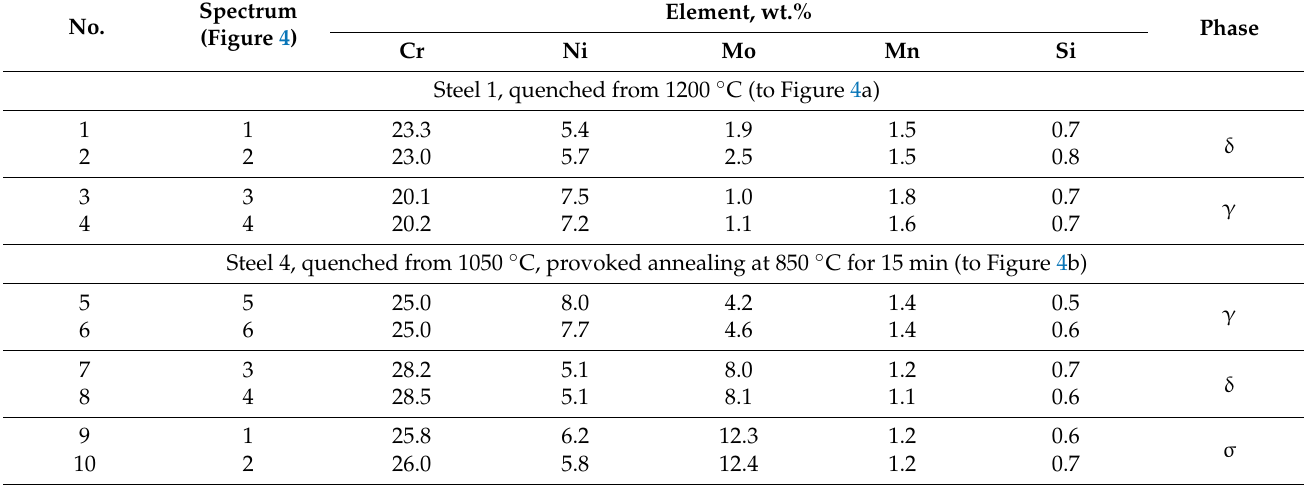
Table 4. Chemical composition of phases in DSSs specimens.